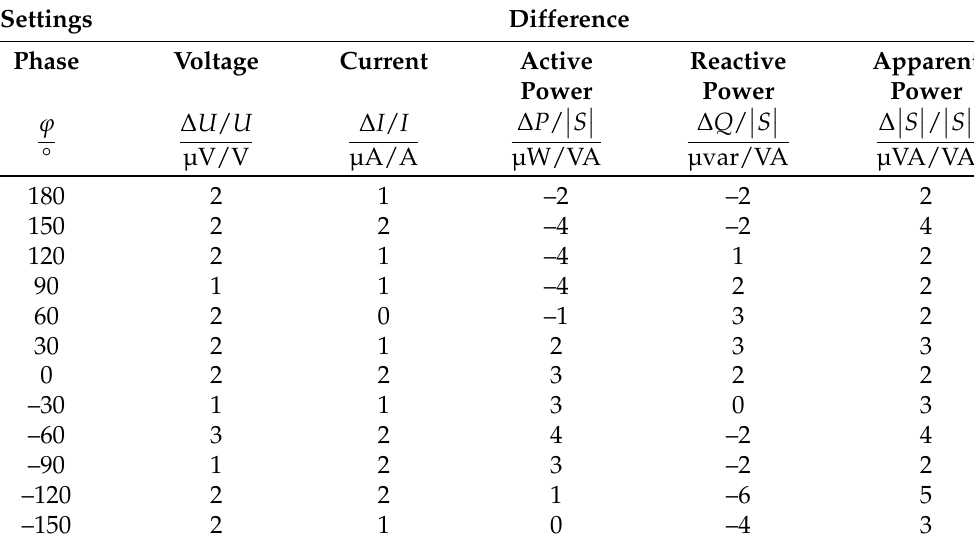
Table 8. Comparison results (240V and